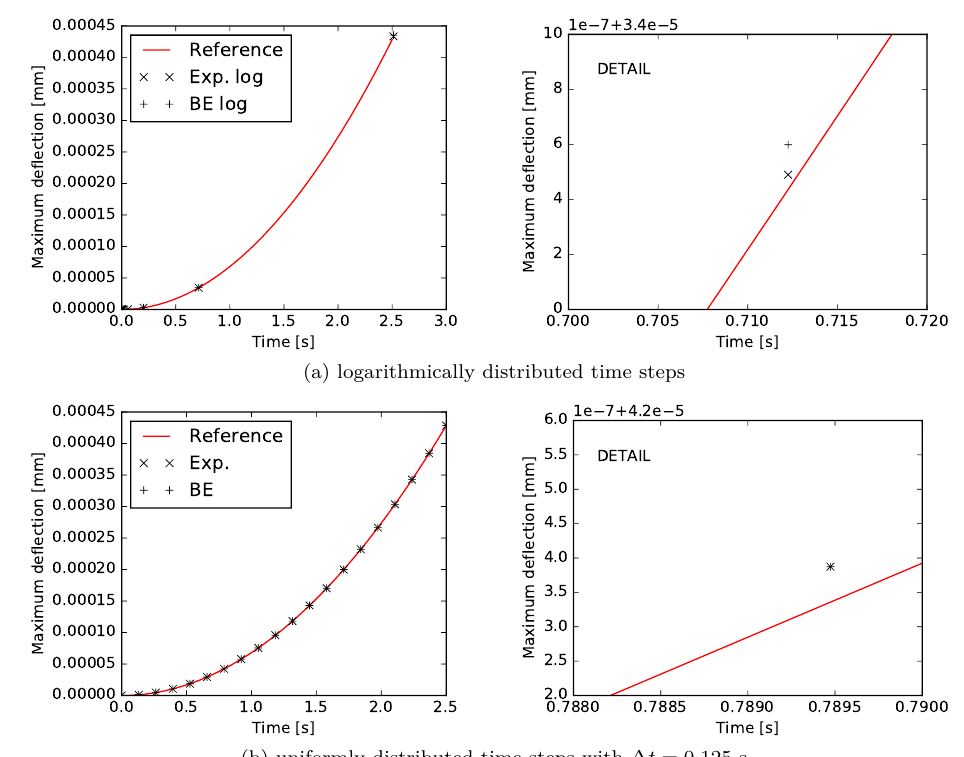
Figure 5. Time evolution of deflection of laminated glass sample under uniformly distributed pressure with quadratically increasing intensity according Figure 3 obtained by: Reference – Backward Euler method with ∆ t = 0 . 05 s, Exp – Exponential algorithm, and BE – Backward Euler method.